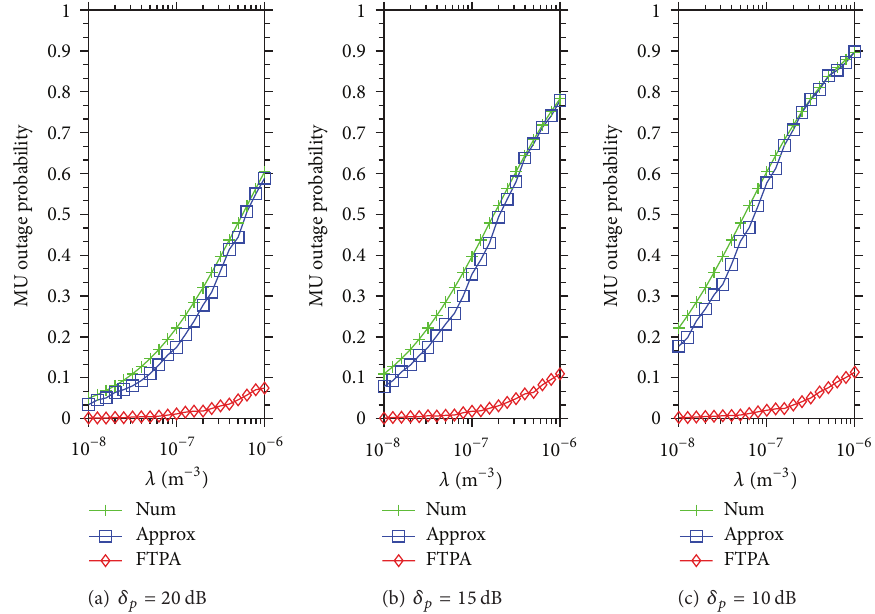
Figure 4: MU outage probability caused by Approx and FTPA versus the density of FBSs development when the QoS type of each MU is data ( 𝜓 5 𝑚 = 2.94